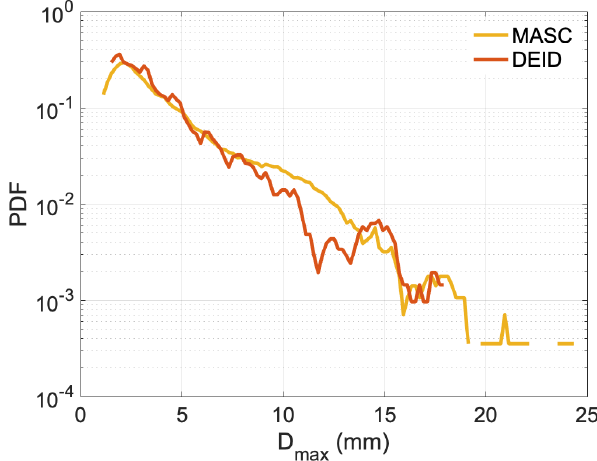
Figure 9. PDF of D max . A total of 2268 snowflakes were ob- served using the DEID and 2093 snowflakes were observed using the MASC during a 1h period on 16 January 2020 at Red Butte